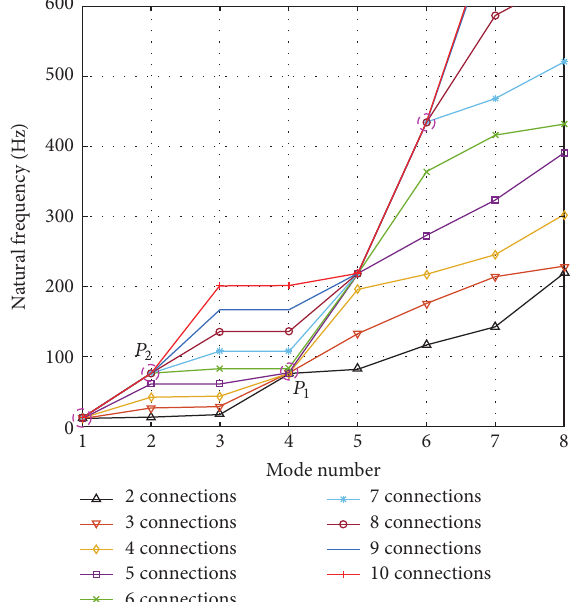
Figure 9: Variation of the natural frequencies with the number of connections when 𝑘 𝑙 = 10 5 N/m.